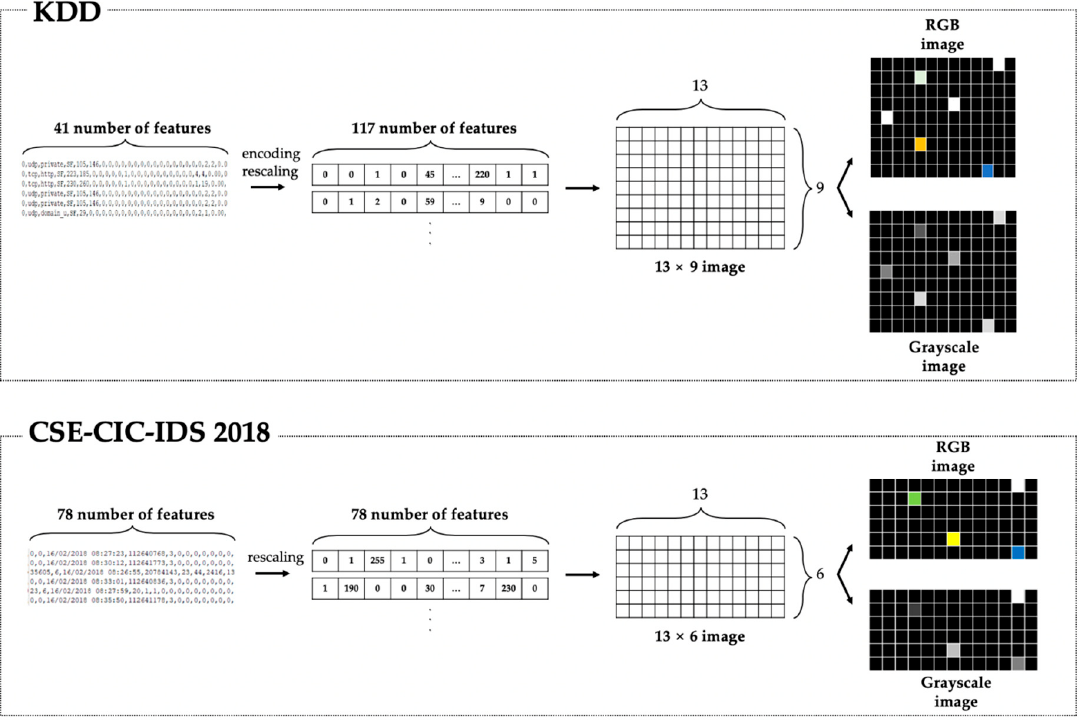
Figure 1. Steps of creating attack images.